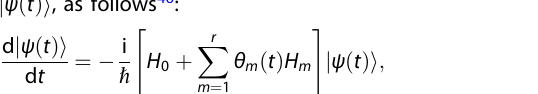
Fig. 1 The training protocol of the quantum end-to-end learning framework. In the k -th iteration, a randomly selected image of a handwritten digit in the MNIST dataset is converted to a vector x ( k ) and then transformed by a matrix W ( k ) to the control variables θ ð k Þ (cid:2) (cid:3) (cid:2) steer the quantum state to ψ ð k Þ ð t E Þ of the qubits in the QNN. This process encodes x ( k ) to ψ ð k Þ (cid:2) (cid:2) (cid:3) (cid:3) (cid:2) (cid:2) to ψ ð k Þ ð t E þ I Þ that is to be measured. The parameters in W ( k ) and θ ð k Þ applied to drive ψ ð k Þ ð t E Þ the loss function L and its gradient obtained from the measurement. The circled numbers represent the speci fi c points in the data fl ow and the corresponding learning performances are shown in Fig. 4. The top right is the false-colored optical image of the six-qubit device used in our